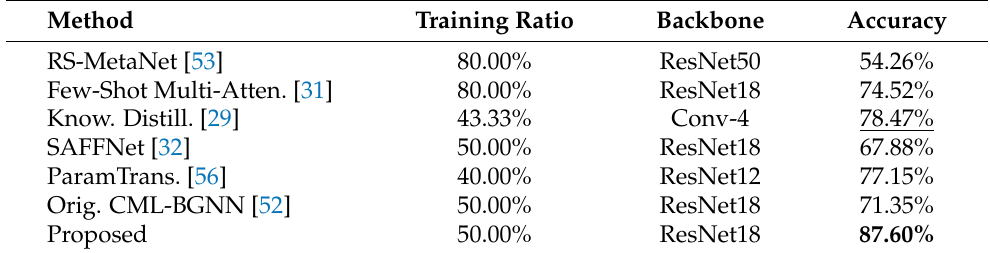
Table 6. Classification accuracies on AID.